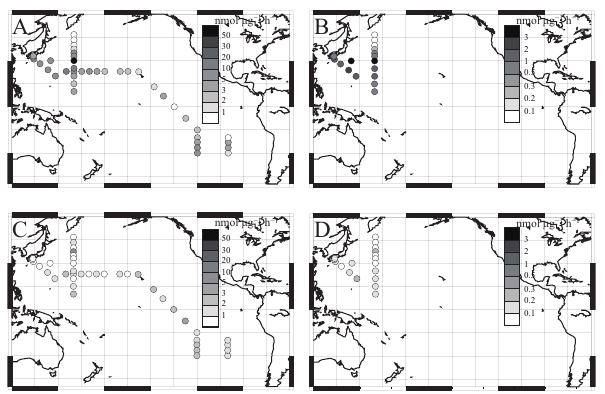
Fig. 3 Fig. 3. Volumetric phosphate monoesterase (A, C) and diesterase (B, D) activities normalized to chlorophyll a concentration through- out the Pacific Ocean. (A) and (B) are from the 10m depth, and (C) and (D) are from the subsurface chlorophyll maximum layer.